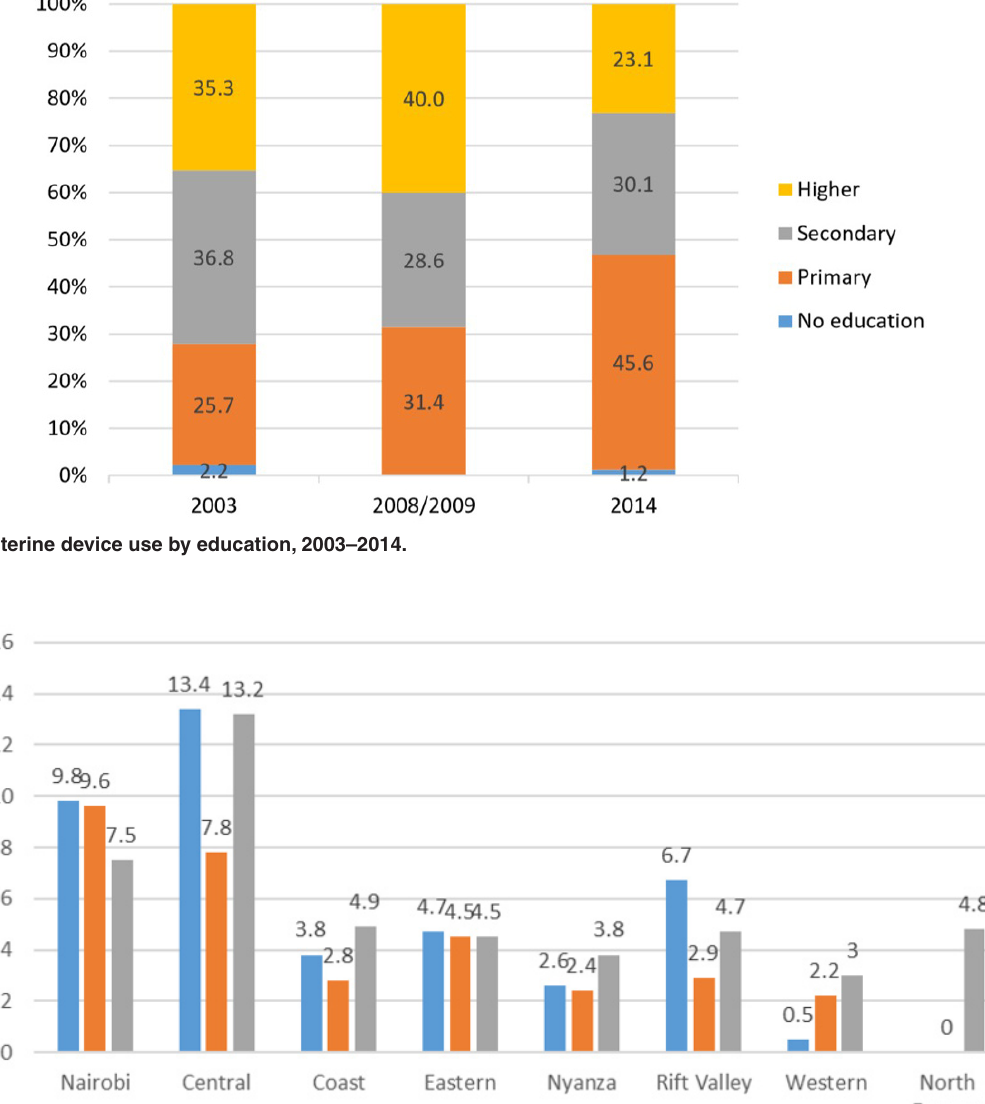
was minimal and was only exhibited for the women aged 25–34, who were 15% more likely to choose LARC than the younger 15-24